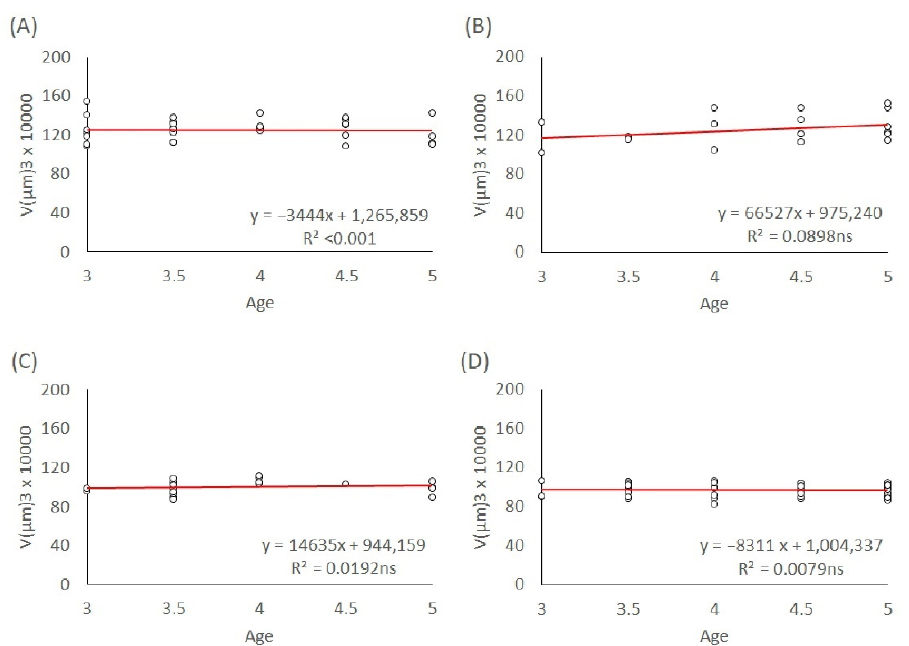
Figure 4. Linear regression of egg size in the maternal age group of 3–5-day-old mothers. ( A ) L1 male eggs, ( B ) L1 female eggs, ( C ) T male eggs, and ( D ) T female eggs. The significance level of the slope: ns (not significant).